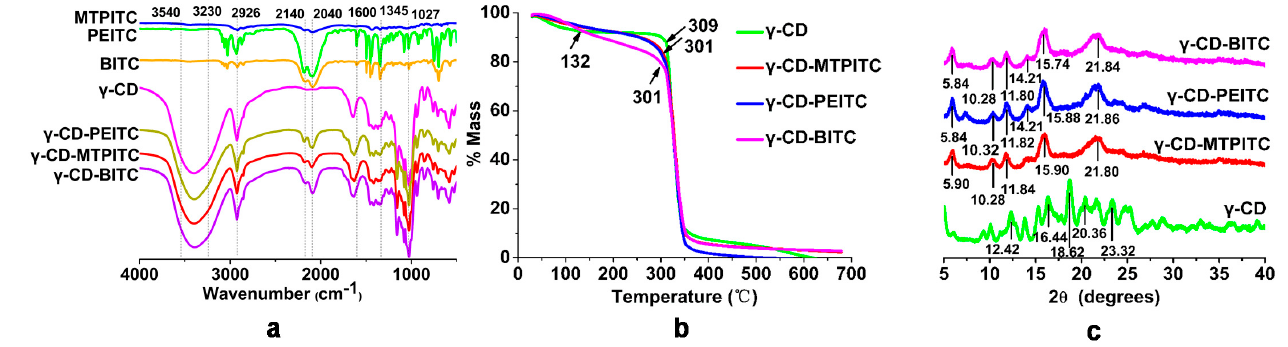
Figure 2. ( a ) FTIR spectra of ITC, γ -CD and γ -CD-ITCs. ( b ) TGA curves for γ -CD and γ -CD-ITCs. ( c ) X-ray diffraction patterns of γ -CD and γ -CD-ITCs.